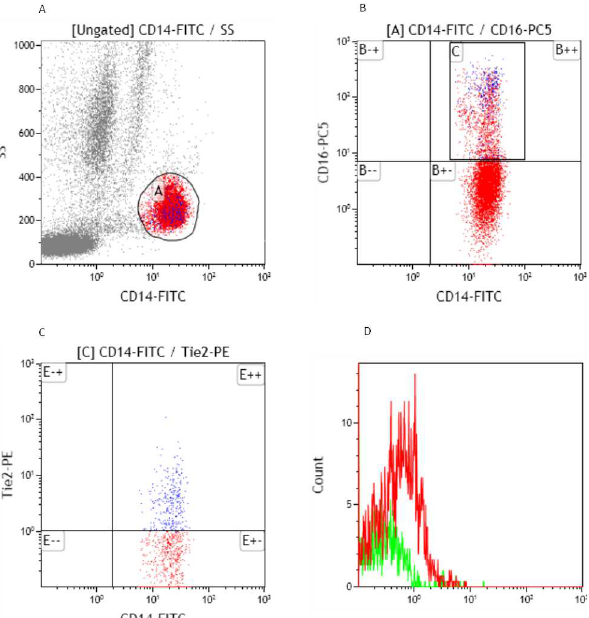
Fig 1. Identification of TEMs as CD14+CD16+TIE2+ cells in peripheral blood. A. CD14+ PBMC obtained from HCC patients were stained and analyzedby flow cytometry. B. CD14+ monocyteswere dividedinto two distinct subsets, CD14+CD16+ and CD14+CD16- cells. C. TEMs were examinedby using TIE2-PE orIgG1-k- PEisotypic antibody. D. The percentage of TEMs in peripheral blood CD14+CD16+ monocytes for this